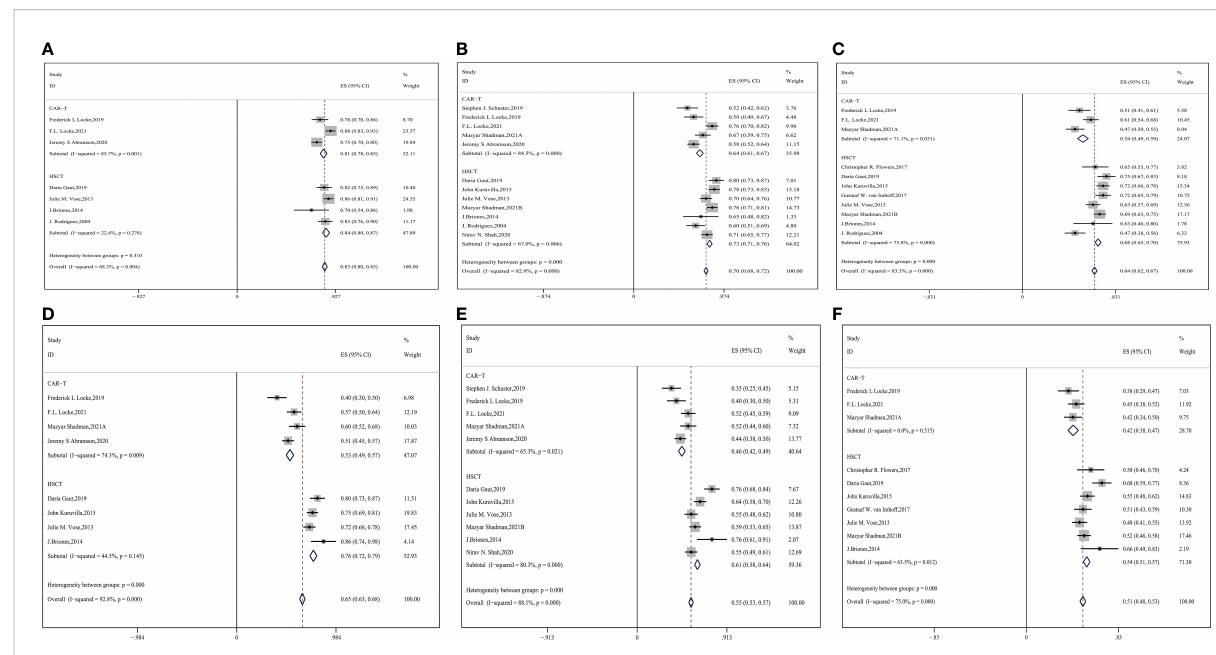
FIGURE 2 Forest plot of OS between CAR-T and auto-HSCT groups (A) 6-month OS (B) 1-year OS (C) 2-year OS Forest plot of PFS between CAR-T and auto-HSCT groups (D) 6-month PFS (E) 1-year PFS (F) 2-year PFS.